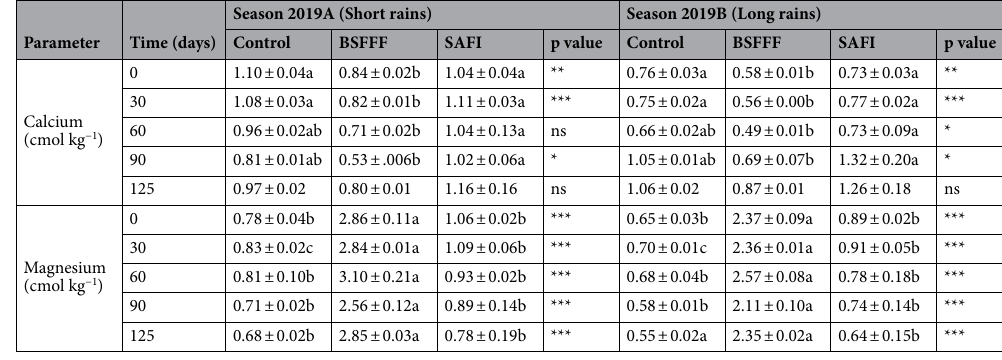
Table 3. Concentrations of exchangeable calcium and magnesium in soil alone and soil amended by BSF frass and commercial organic fertilizers during the short and long rainy seasons. ***p < 0.001, **p < 0.01, *p < 0.05, ns = not significant at p ≥ 0.05 BSFFF = Black soldier fly frass fertilizer, SAFI = commercial organic fertilizer, control = unamended soil. Within the same row and per parameter, means (± standard error) followed by the same letters are not significantly different at p ≥ 0.05, n = 3.